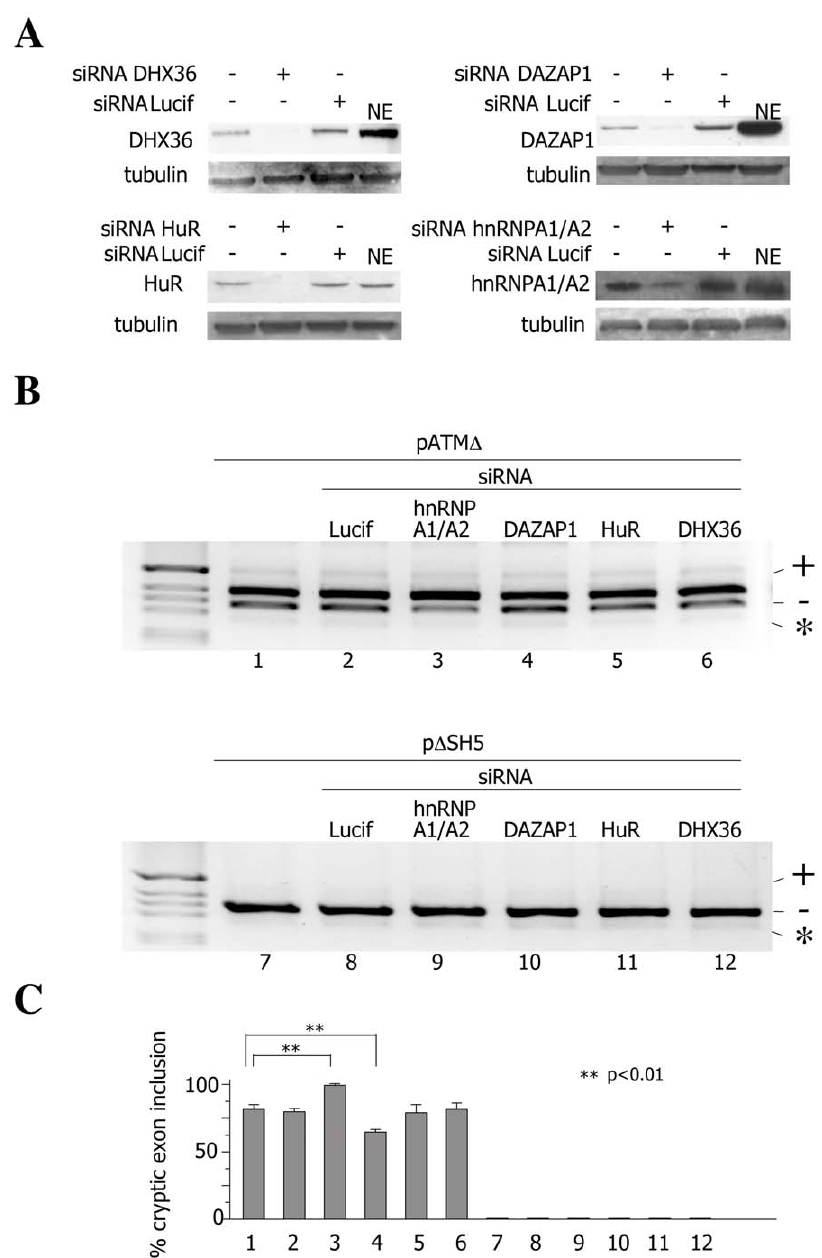
Figure 4. Depletion of hnRNPA1 and DAZAP1 affects splicing of ISE-containing pATM D construct. A) Western blot analysis of HeLa cells treated with siRNA oligonucleotides against RNA helicase DHX36, DAZAP1, HuR and hnRNPA1 protein. siRNA against luciferase was used as a control. The western blot was carried out using antibodies that were specific for each target protein. Tubulin was used as a control of the amount of protein loaded on gel. NE stands for nuclear extract. The siRNA experiment is representative of two independently performed experiments. Protein depletion observed was almost complete. B) siRNA-treated and untreated HeLa cells were transfected with pATM D and p D SH5 minigene constructs and the splicing pattern was analyzed by RT-PCR. RT-PCR fragments were resolved on 2% agarose gel. M is the molecular weight marker. The resulting splicing products with cryptic exon inclusion ( + ) or exclusion (-) are indicated. The identity of siRNAs that were used to knock-down corresponding proteins is indicated. C) The graph is the quantification of three independent experiments expressed as means 6